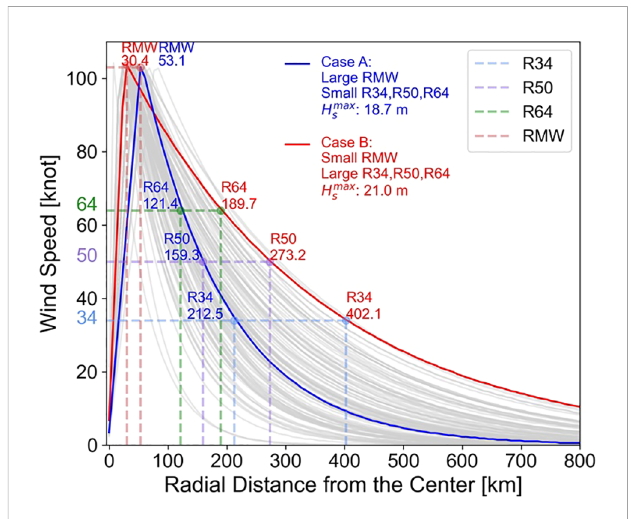
FIGURE 1 Radial wind pro fi les (gray lines) of TCs with MWS of 105 knots. The gray lines are from 105 North Atlantic hurricanes from 1988 to 2017 using extended best-track data, from which the blue (Case A) and red (Case B) lines were selected for a case study. The values of the four TC wind radii and simulated H max s for the two selected pro fi les are shown. Dashed lines indicate the radius of maximum wind (RMW) and the 34-, 50-, and 64-knot wind radii (R34, R50, and